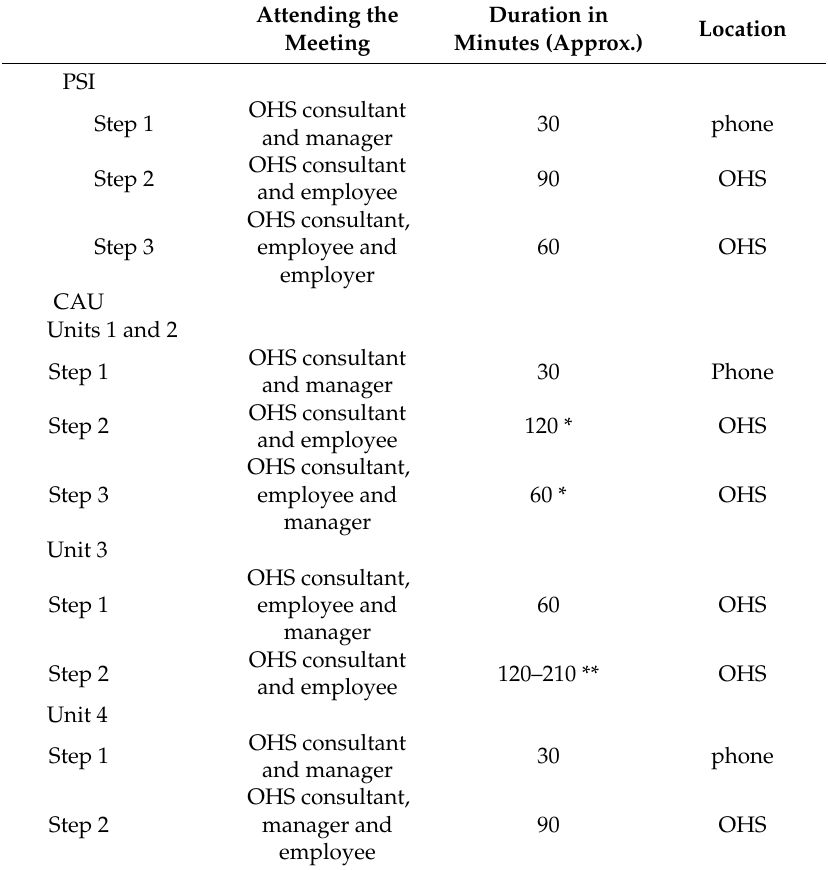
Table 3. CAU at the Di ff erent OHS